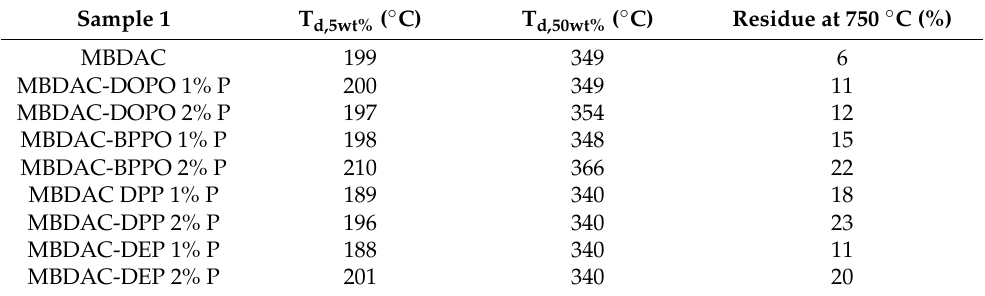
Figure 2. TGA thermograms of PHU materials. Table 2. Results of TGA analyses on materials.